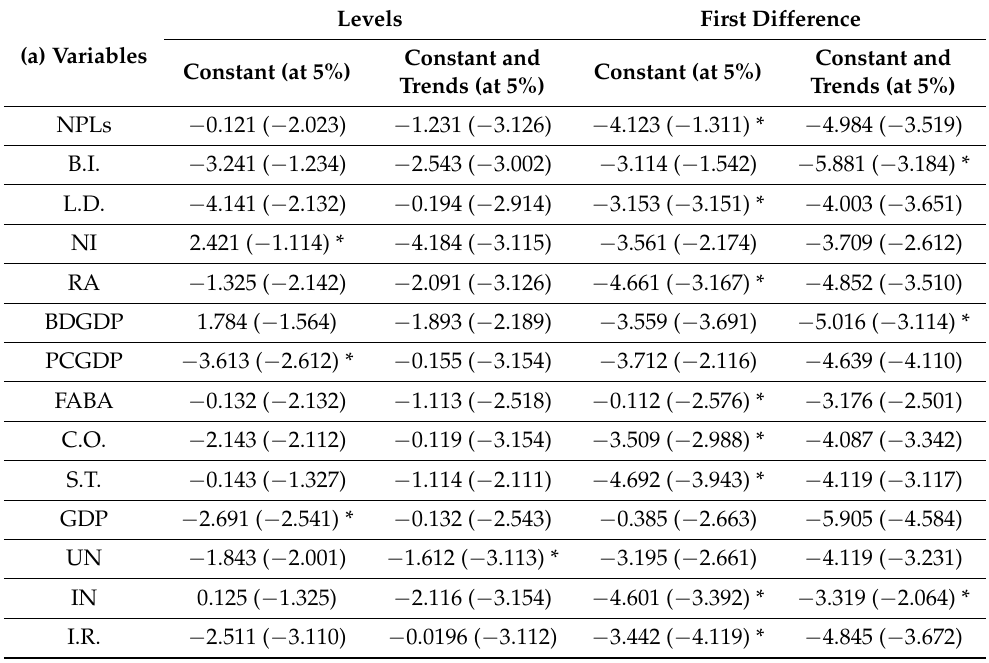
Table 3. ( a ): Augmented Dicky Fuller Unit root test result. ( b ): CIPS unit root test